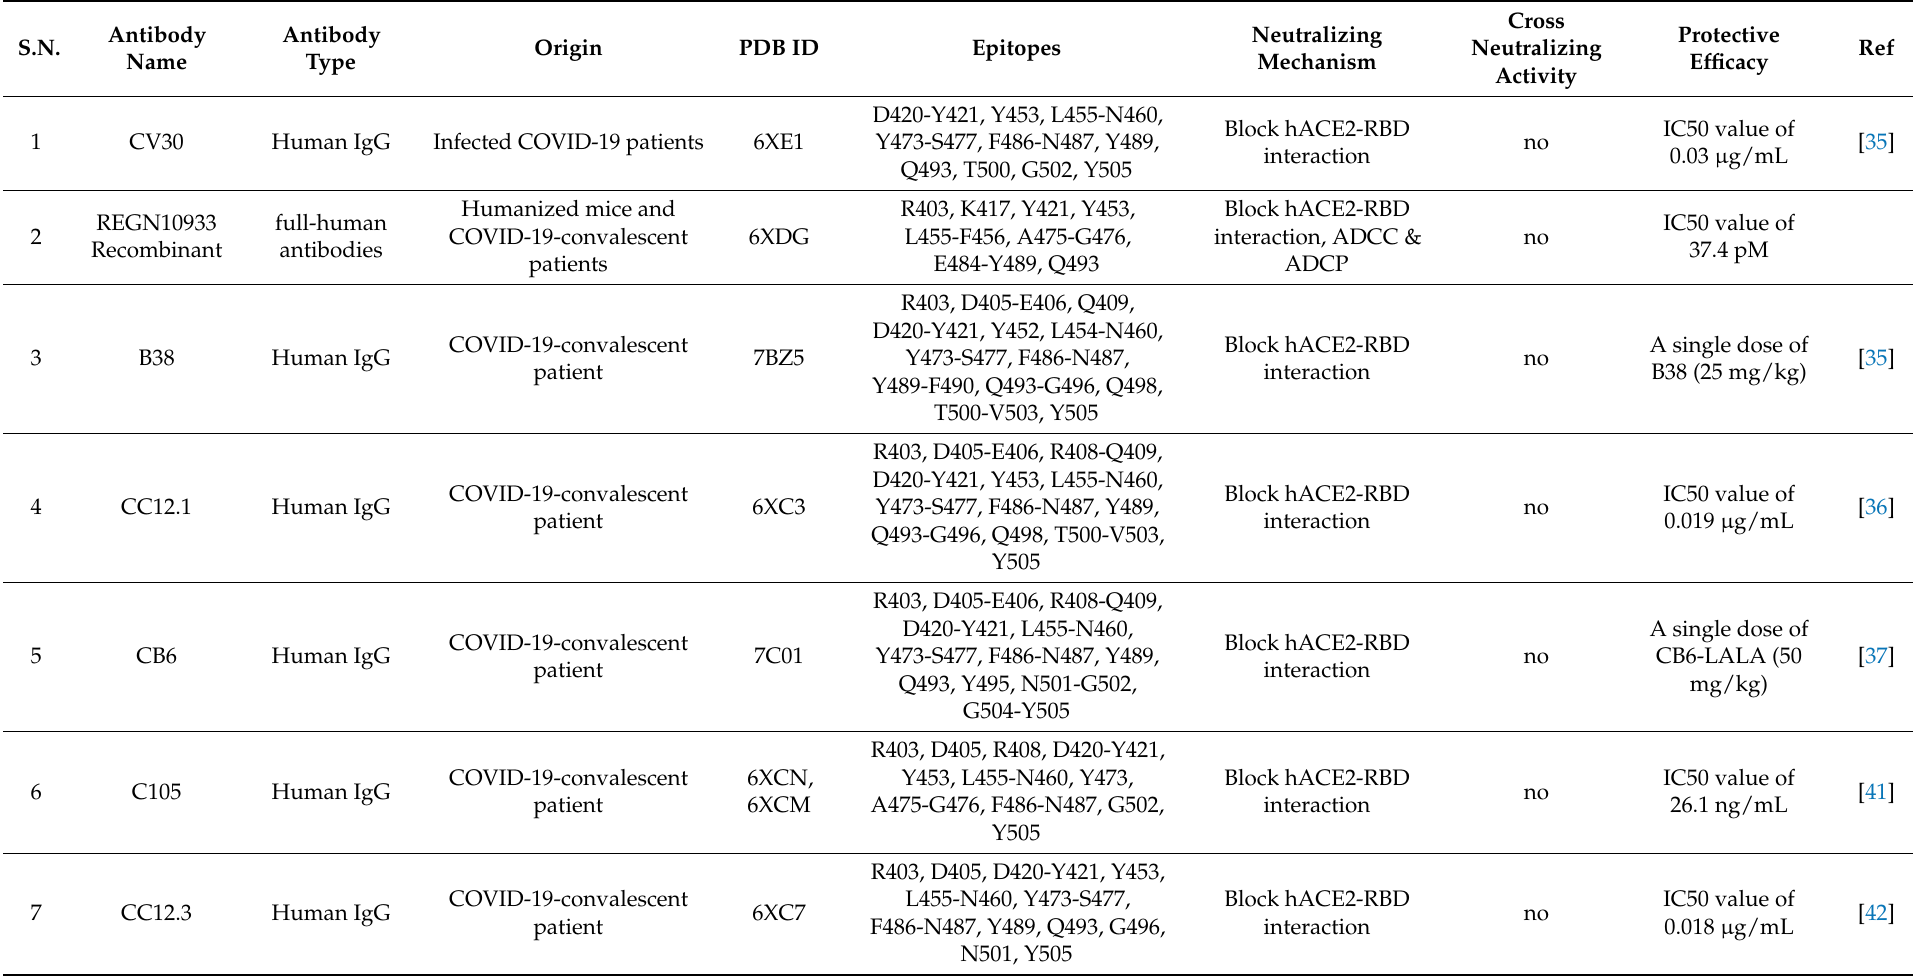
Table 3. Neutralizing antibodies against